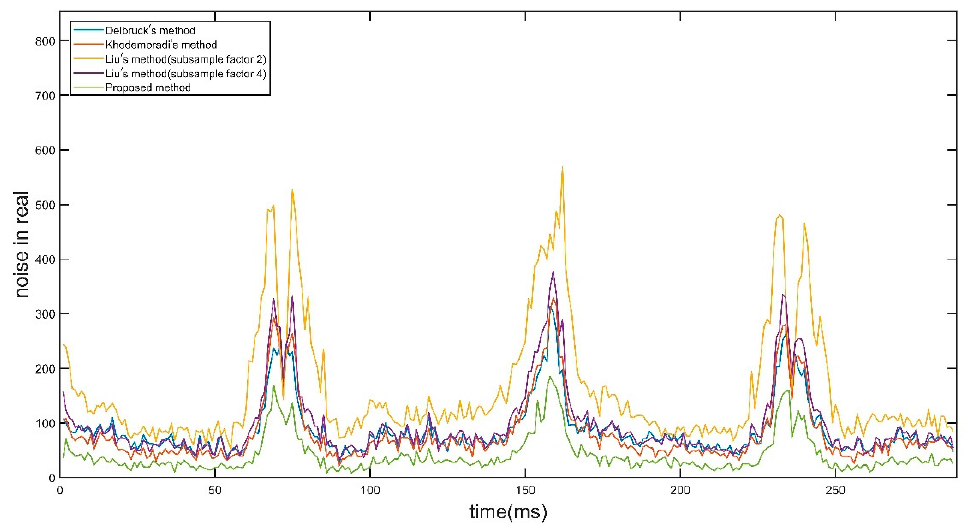
Figure 14. Noise in real (NIR) for each time period.